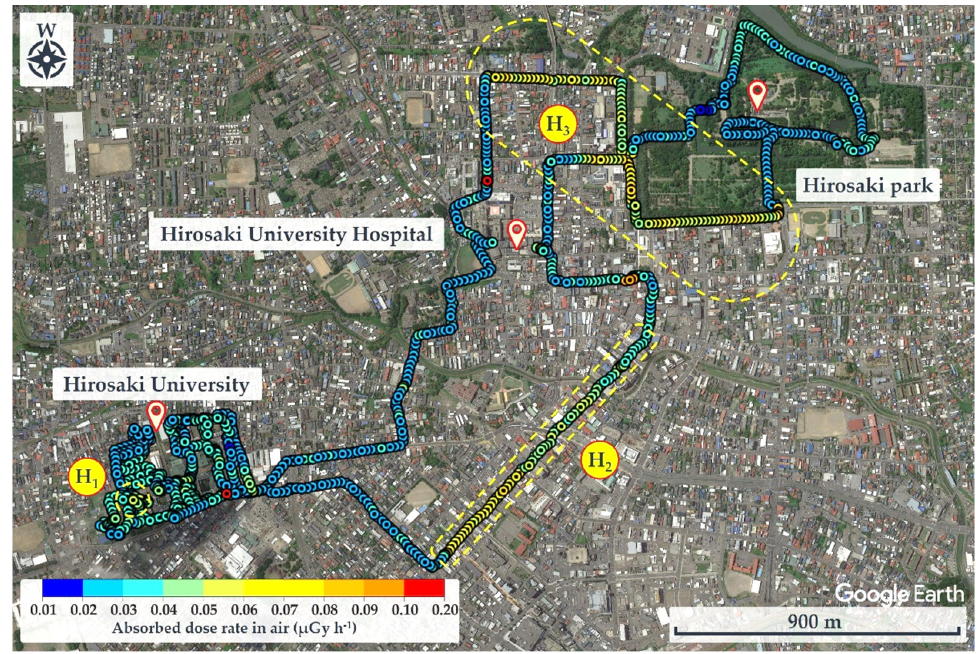
Figure A1. Distribution map of absorbed dose rate in air at Hirosaki City.